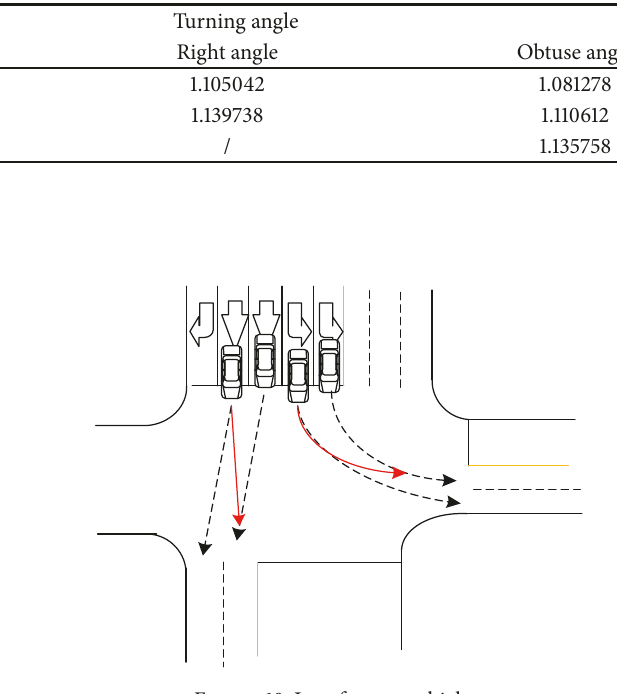
Figure 10: Interference